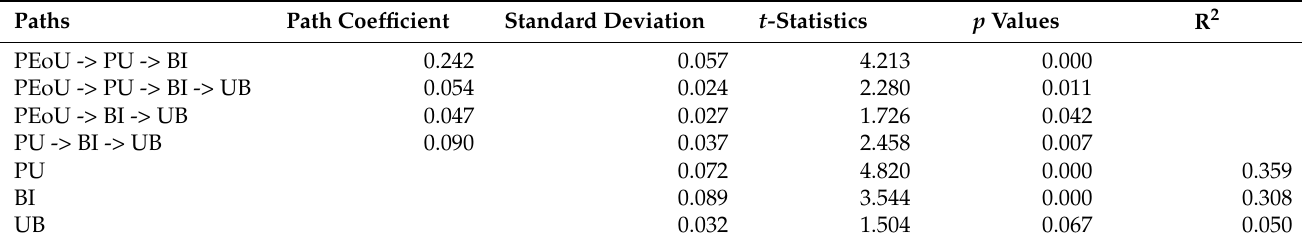
Table 5. Specific indirect